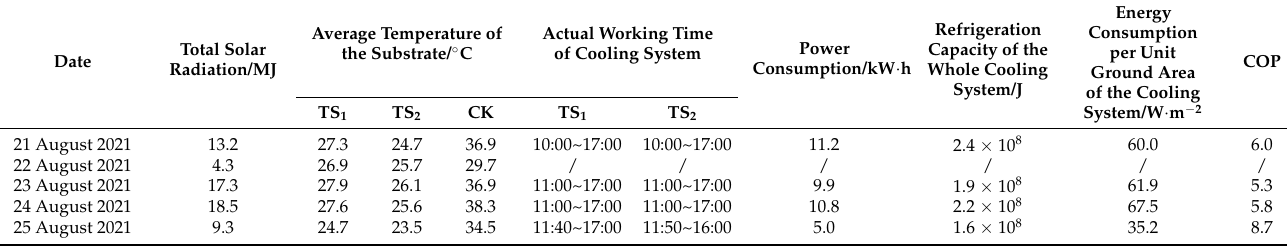
Table 7. Cooling performance of